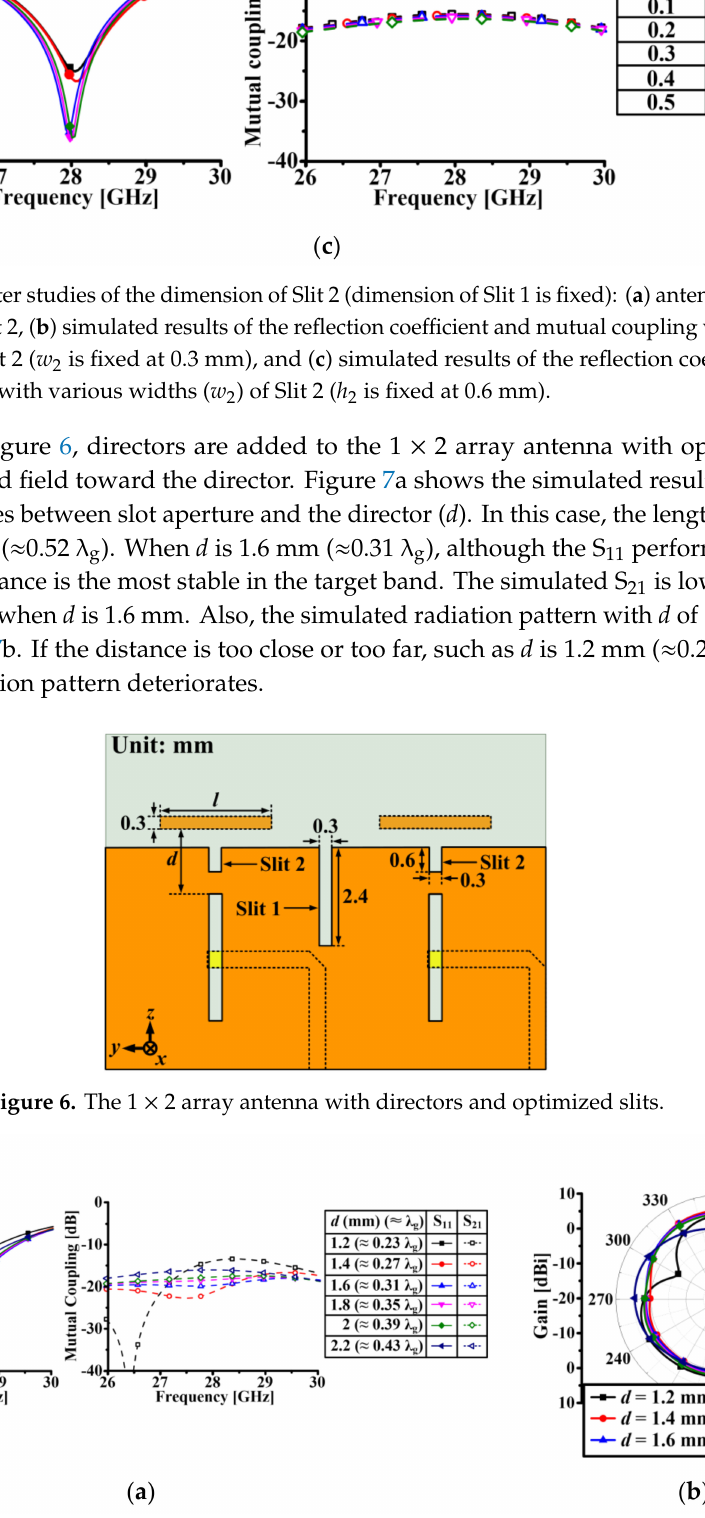
Figure 7. Parameter studies of the distance between the slot aperture and the director ( l is fixed at 2.7 mm): ( a ) simulated results of the reflection coe ffi cient and mutual coupling with various distances ( d ), and ( b ) simulated radiation patterns with various distances ( d ) in the xz plane at 28